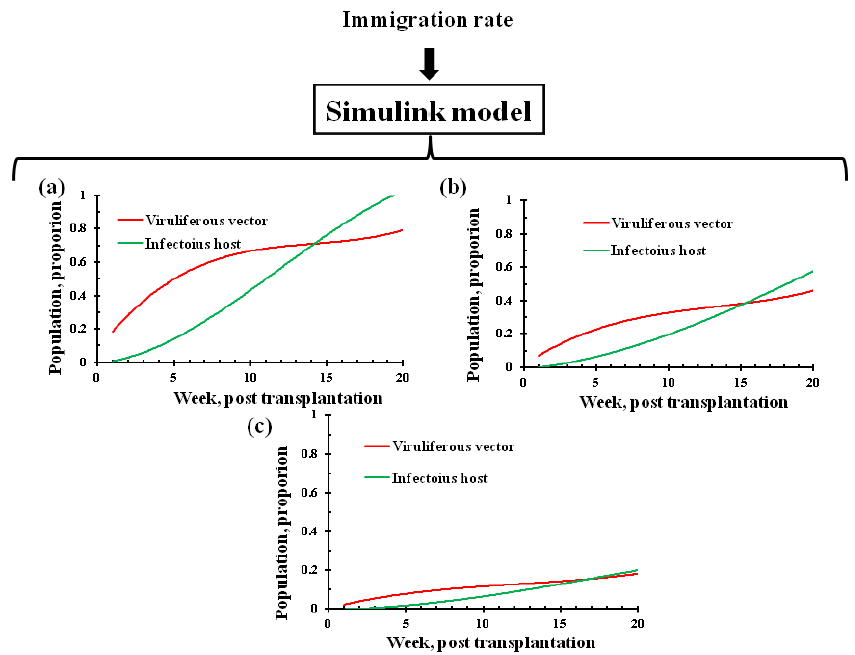
Figure 2. Leaf curl epidemic risk (as infectious host and viruliferous vector population) in relation to migration rate (viruliferous vectors); epidemic level with migration or immigration rate 0.2 ( a ), 0.07 – 0.1 ( b ), and 0.03 – 0.05 ( c ) vector/plant/week.